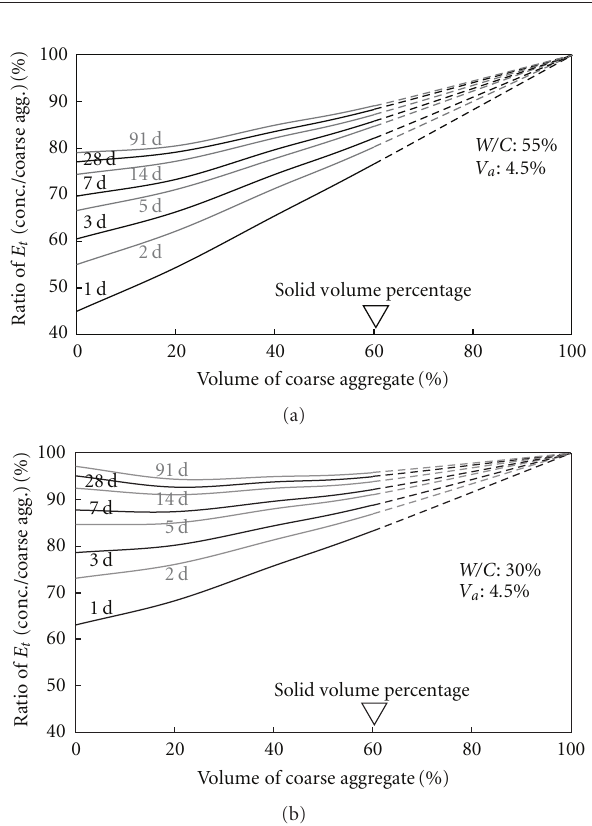
Figure 17: Prediction results for tensile Young’s modulus of concrete: (a) W/C = 55% and (b) W/C =